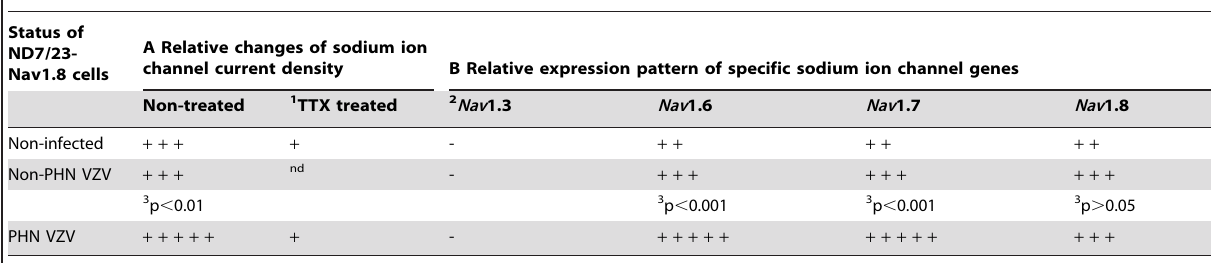
Table 2. Trends in (A) sodium ion channel current densities and (B) sodium ion channel mRNA levels in PHN, non-PHN and non- infected ND7/23-Nav1.8